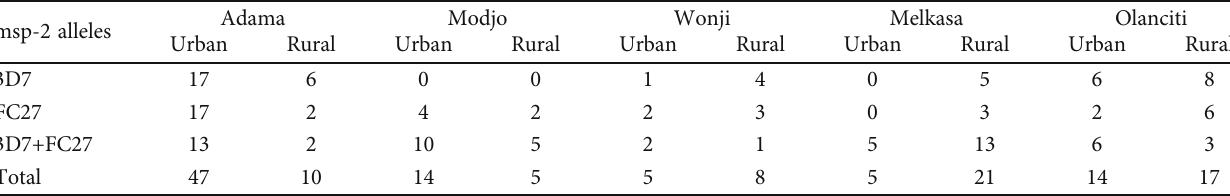
Table 2: Urban and rural distribution of P. falciparum msp-2 alleles isolated from symptomatic patients across sample collection sites from Adama and its surroundings ( n = 148 ).